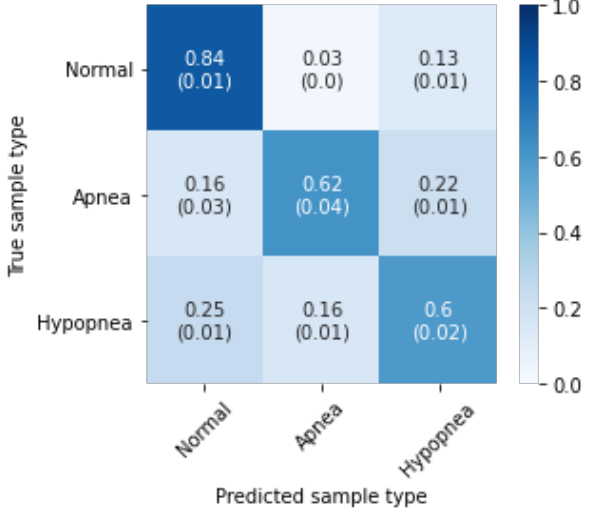
Figure 11. Three-class inference confusion matrix, mean and standard deviation from 5 experiment iterations on PhysioNet Sleep Database, without additional episode marking based on the N class probability. Values are row-normalized and rounded to two decimal places.